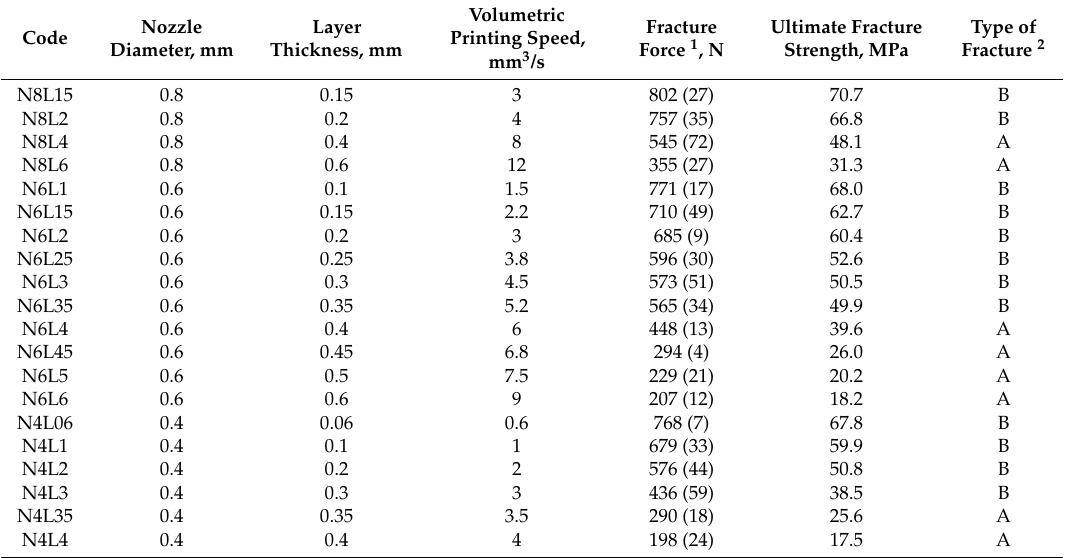
Table 1. Experimental data on the influence of geometrical parameters of 3D printing (nozzle diameter and layer thickness) on the fabricated components’